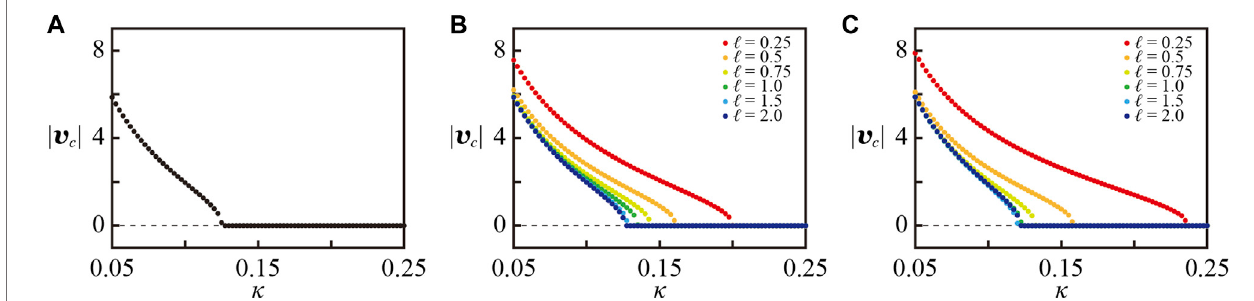
FIGURE2| Numericalresultsonthestationarytranslationalvelocityofthecamphor fl oat. (A) Asinglecamphordisk. (B) Thecamphor fl oatwithtwocamphordisks. (C) The camphor fl oat with three camphor disks. For the cases (B,C) , the results for various ℓ were represented in different colors.